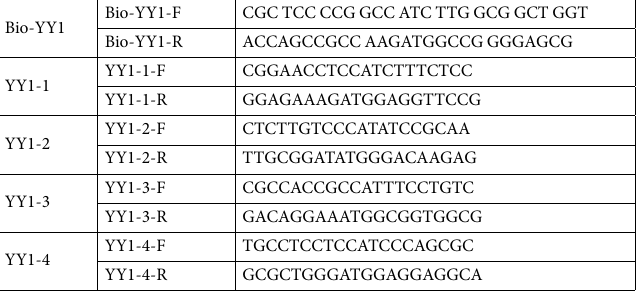
Table 1. The sequences of biotin-labeled DNA probes and wide-type